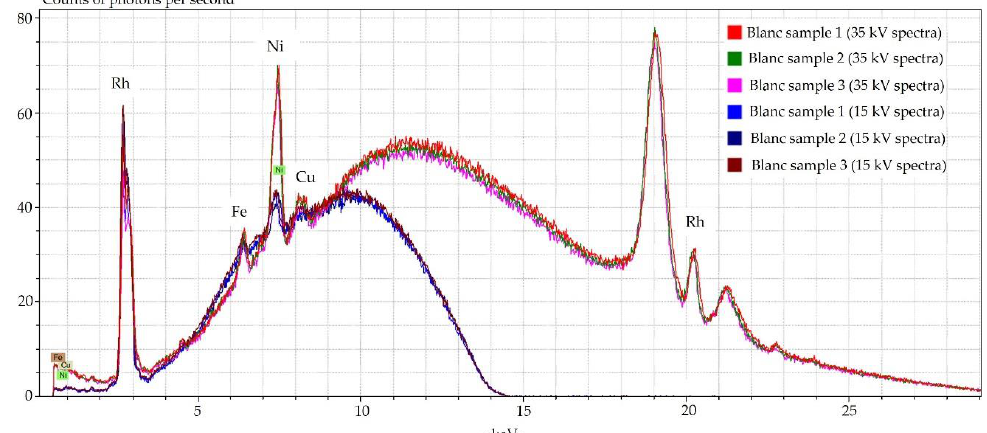
Figure A1. Spectra of the blanc sample obtained during the XRF data acquisition using the X-ray tube configured at 15 and 35 kV. The spectra acquired at the beginning, after 50 samples, and at the end of the measurements are designated in the legend as Blanc sample 1, 2, and 3, respectively.